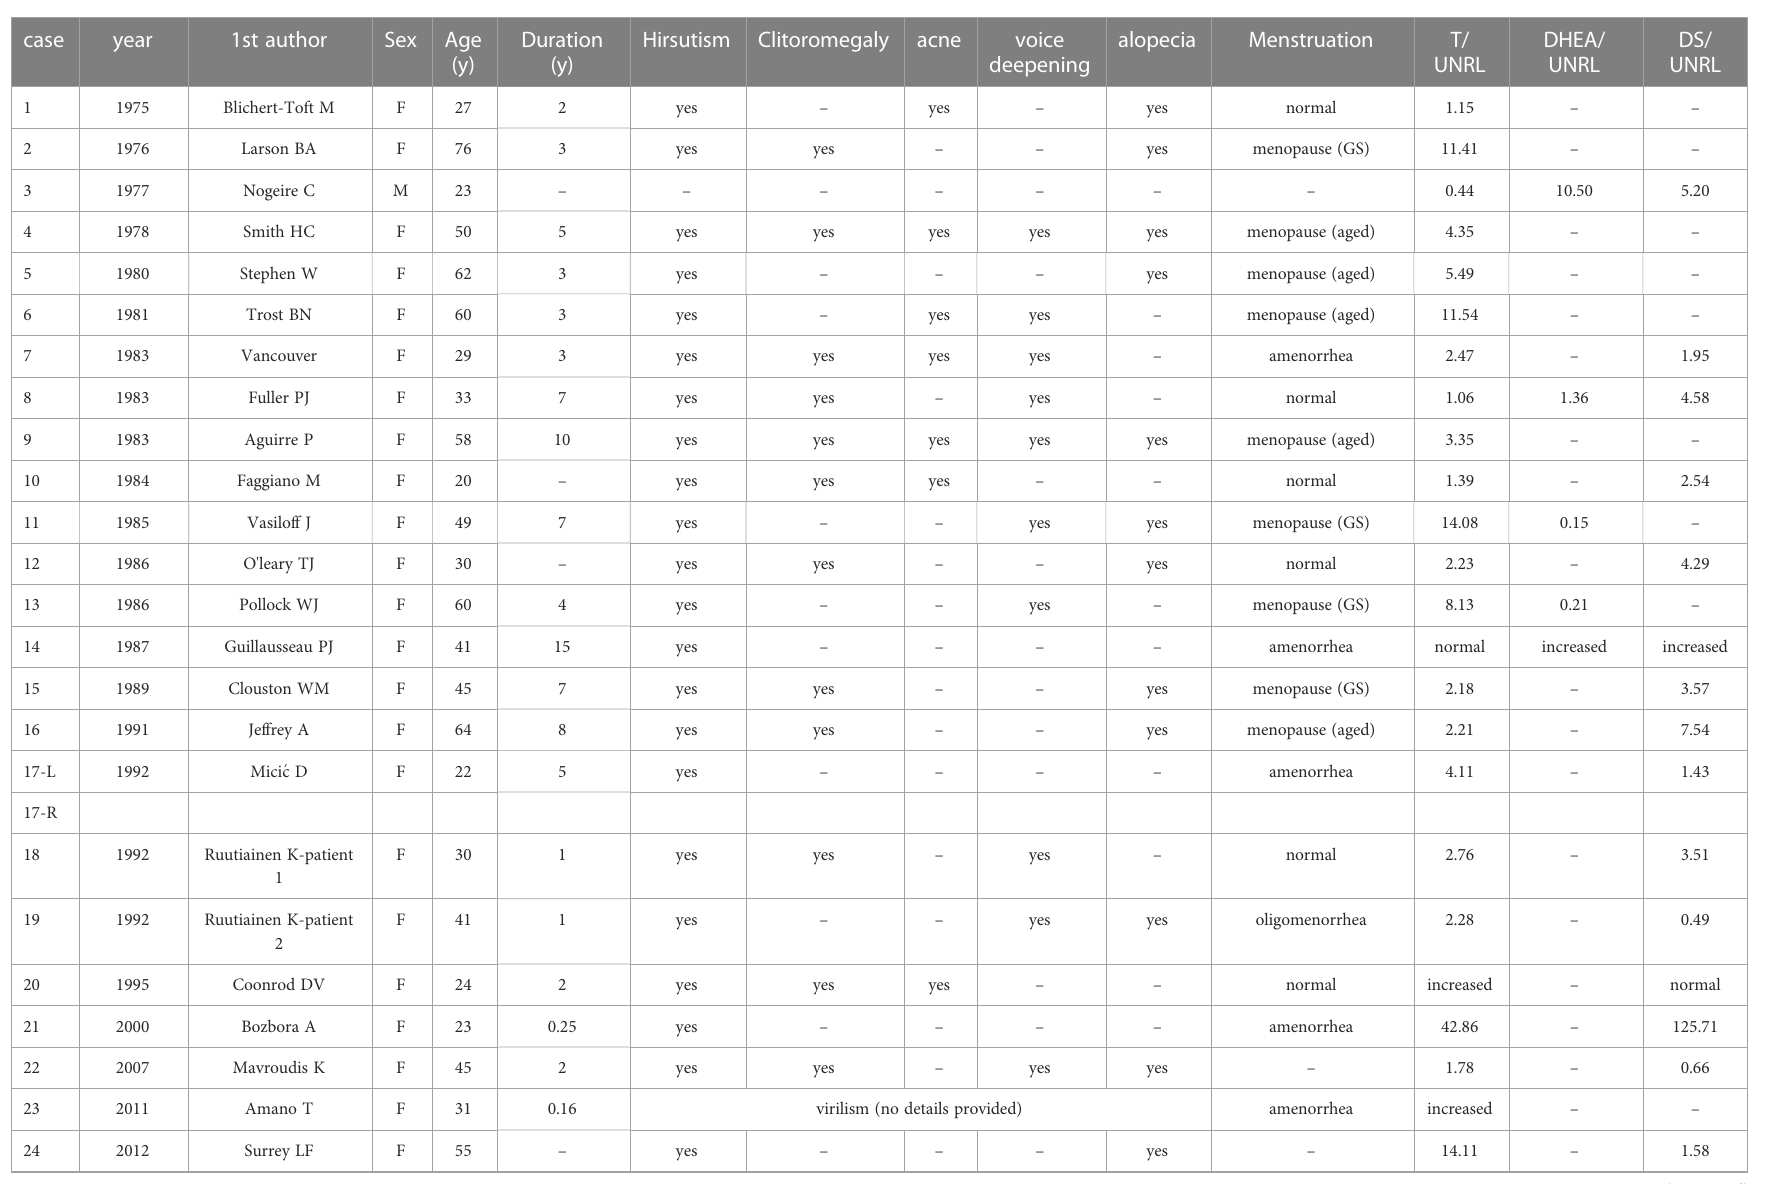
TABLE 2 Characteristics of adult PASAT: summary of case reports (including current